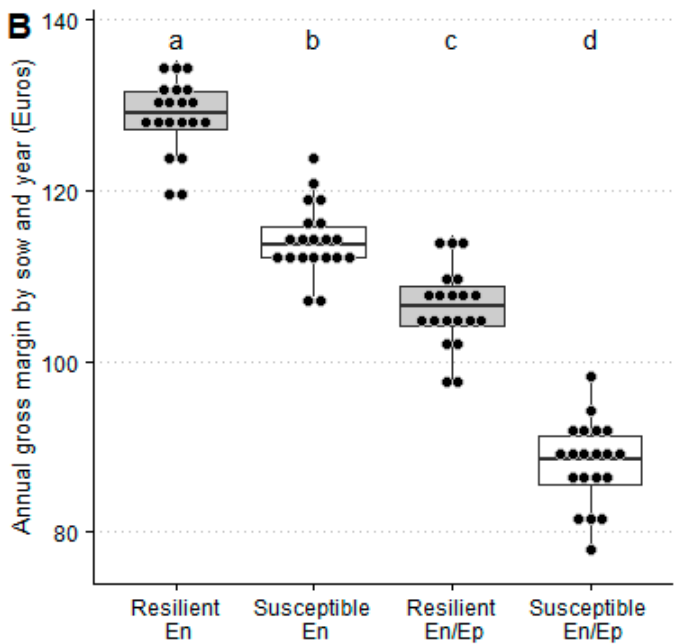
Figure 5. Piglet production cost (Euros) ( A ) and gross margin ( B ) (Euros by year and sow) for PRRSV resilient and susceptible sows in a PRRSV endemic-infected farm not suffering (En) or experiencing (En/Ep) one epidemic PRRSV outbreak with an average duration of 24 weeks within three years. Bars with different superscripts showed statistically significant differences ( p < 0.05).